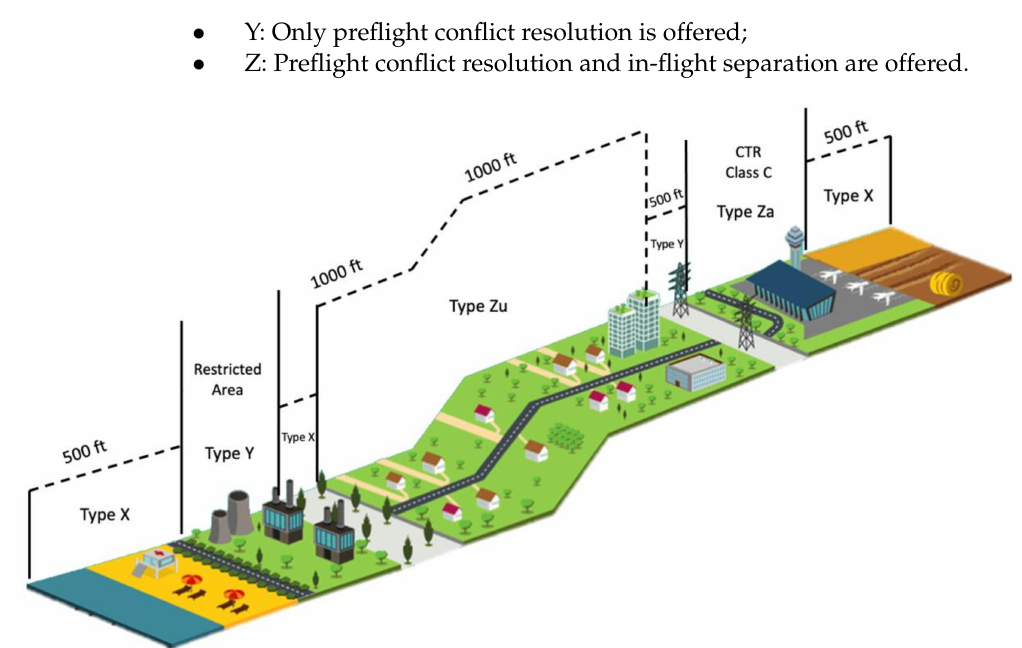
Figure 3. Classification of airspace adapted from the CORUS project [26]. The VLL airspace is divided into X, Y, Z volumes: X (low risk), Y (higher risk—access only with approved operation plan and specific technical requirements per volume) and Z (highest risk—access only with approved operation plan being Zu under U-space and Za the ATC controlled